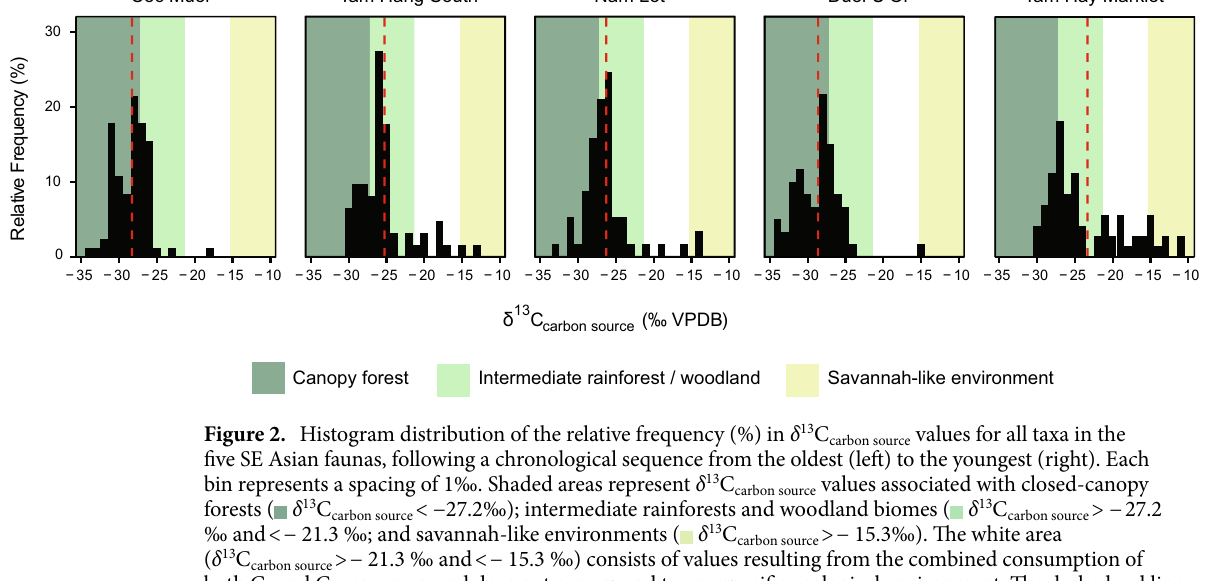
Figure 2. Histogram distribution of the relative frequency (%) in δ 13 C carbon source values for all taxa in the five SE Asian faunas, following a chronological sequence from the oldest (left) to the youngest (right). Each bin represents a spacing of 1‰. Shaded areas represent δ 13 C carbon source values associated with closed-canopy forests ( δ 13 C carbon source < −27.2‰); intermediate rainforests and woodland biomes ( δ 13 C carbon source > − 27.2 ‰ and < − 21.3 ‰; and savannah-like environments ( δ 13 C carbon source > − 15.3‰). The white area ( δ 13 C carbon source > − 21.3 ‰ and < − 15.3 ‰) consists of values resulting from the combined consumption of both C 3 and C 4 resources, and does not correspond to any specific ecological environment. The dashed red line represents the mean δ 13 C carbon source value in each site.